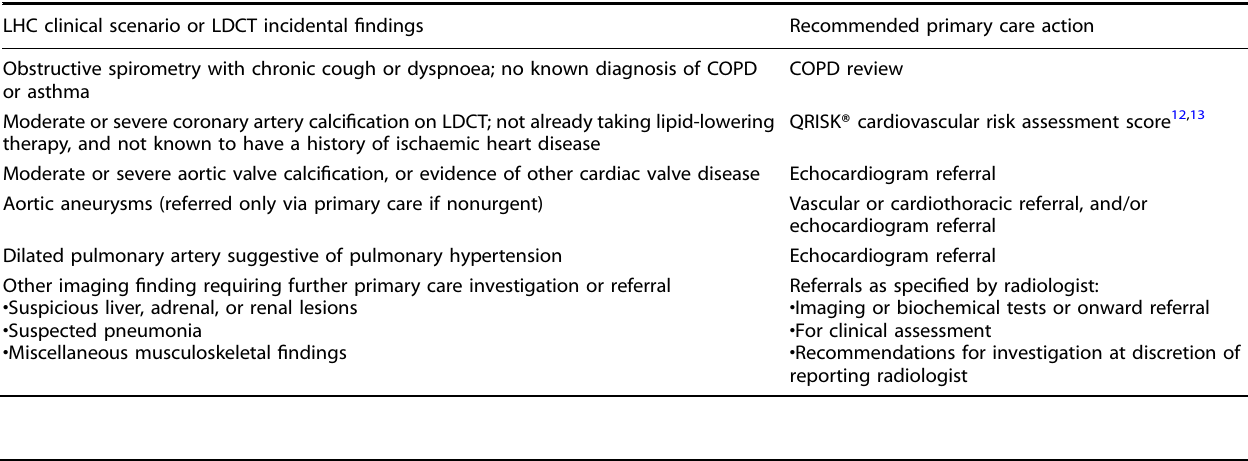
Table 3. Indications for referral to primary care and recommended primary care actions.